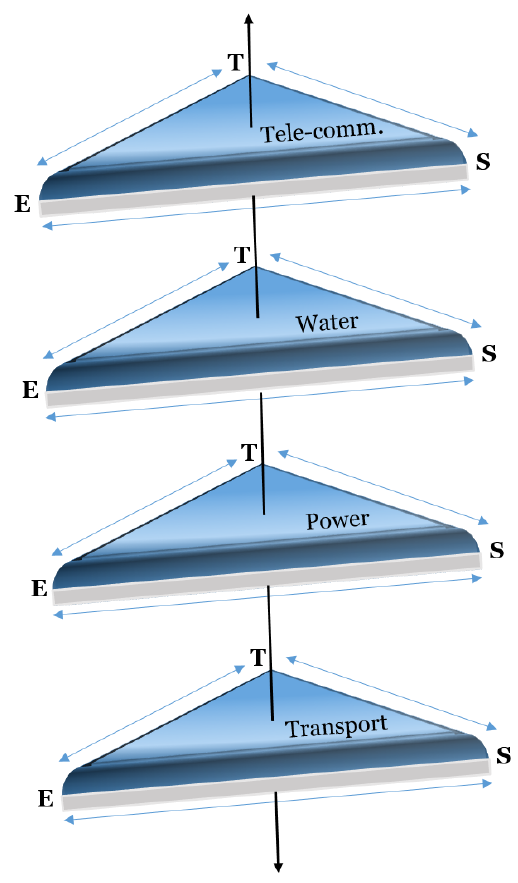
Figure 2. Schematic representation of different types of VIS, show- ing the cross-sectoral dependencies between the four types of infras- tructures, as well as the interrelations within each system between technical (T), ecological (E), and social (S)